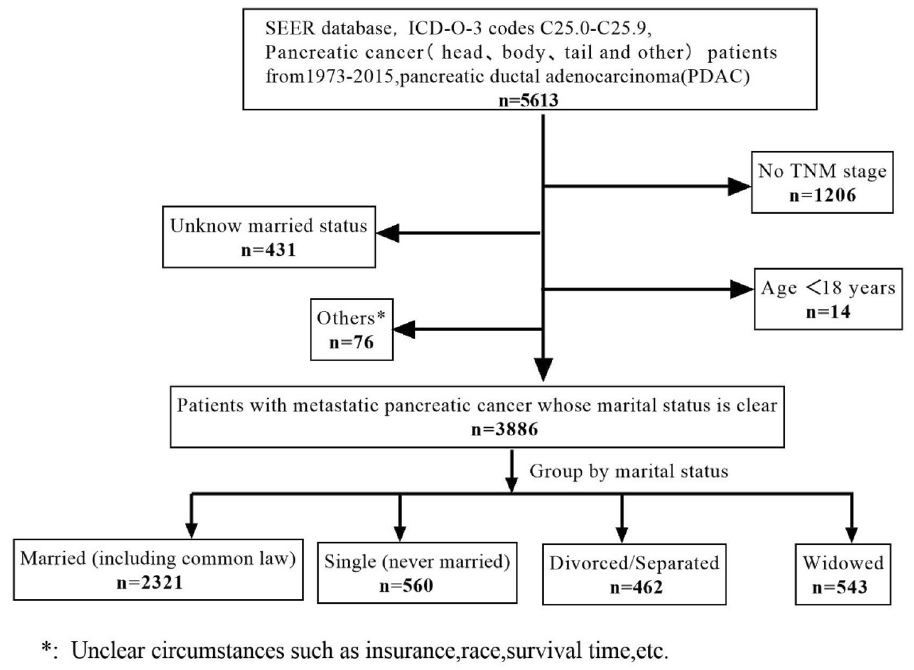
Figure 1. A flow diagram showing the study selection